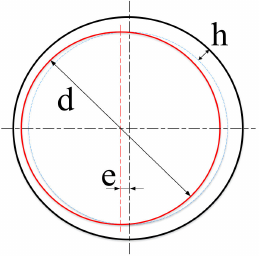
Figure 19. Radial clearance of hydraulic cylinder.